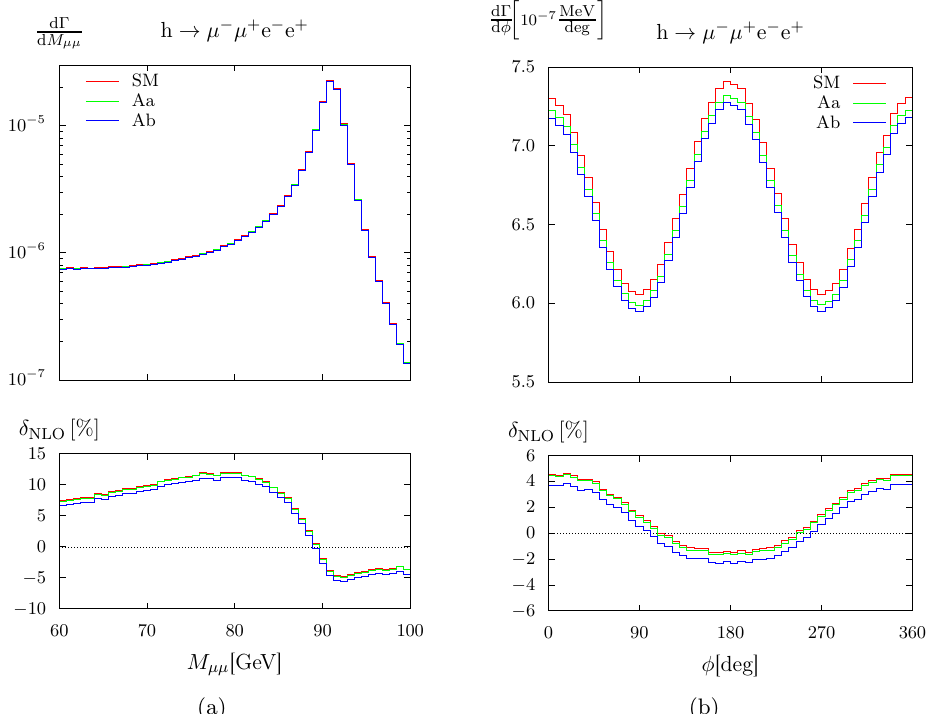
Figure 17 . Invariant-mass (a) and angular distributions (b) of the leptonic neutral-current decay h (cid:22) (cid:0) (cid:22) + e (cid:0) e + for the SM and the THDM benchmark scenarios Aa and Ab. The relative NLO ! corrections to the distributions are plotted in the lower panels. In the upper row left, all curves nearly coincide, while in the lower row, the SM prediction is close to the THDM prediction of scenario